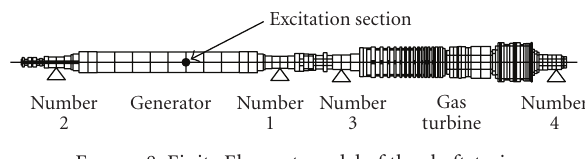
Figure 8: Finite Element model of the shaft-train.